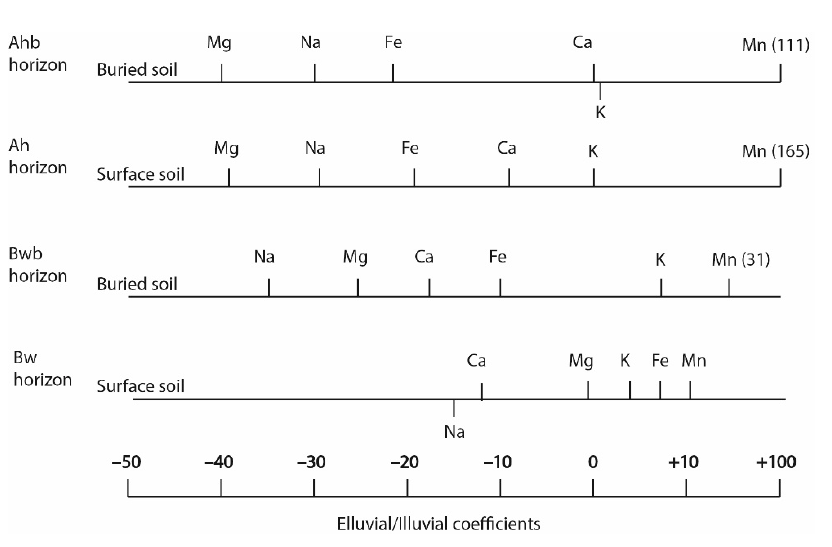
Figure 9. Elluvial/illuvial coefficients for the buried and the surface soils.